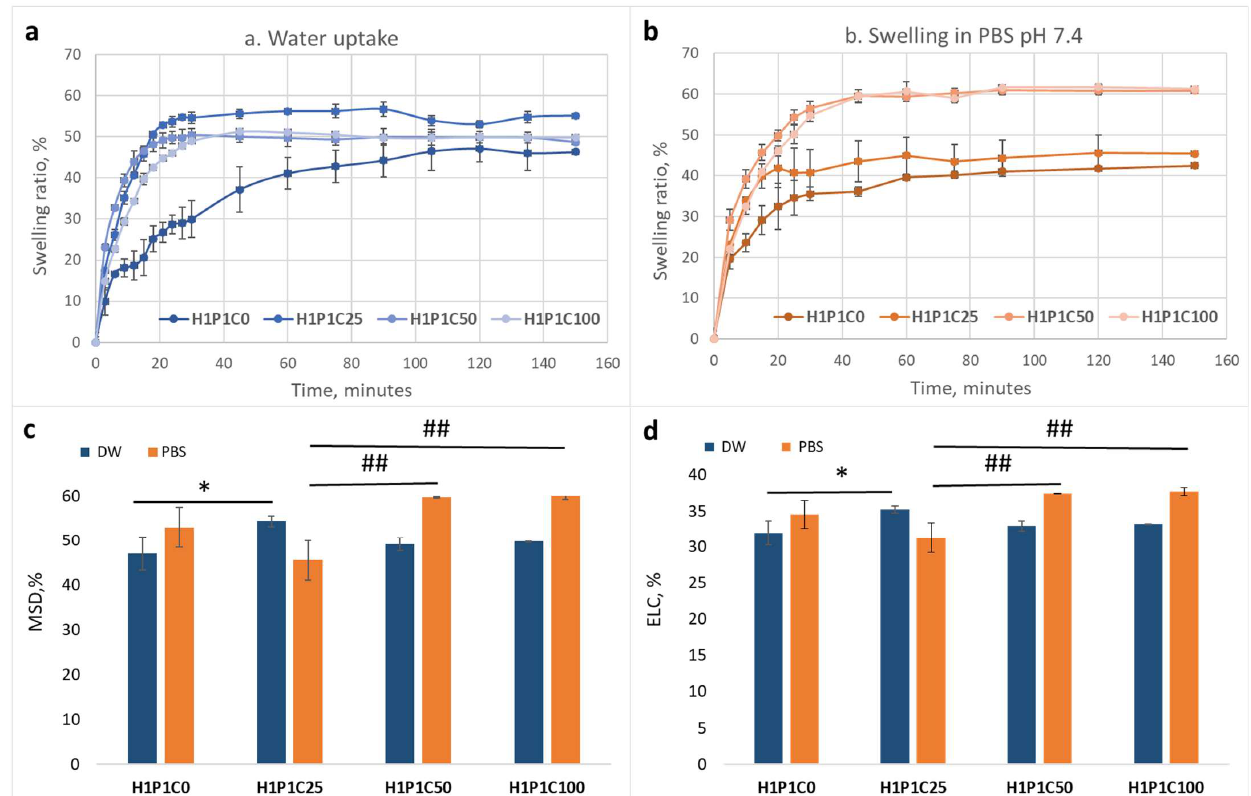
Figure 4. Influence of casein content on: ( a ) water uptake; ( b ) swelling behaviour in PBS pH 7.4; ( c ) maximum swelling degree, MSD, in DW and PBS pH 7.4; ( d ) equilibrium liquid content, ELC, in DW and PBS pH 7.4 (statistical significance: * p < 0.05, ** p < 0.01, *** p < 0.001 for DW; statistical significance: # p < 0.05, ## p < 0.01, ### p < 0.001 for PBS).